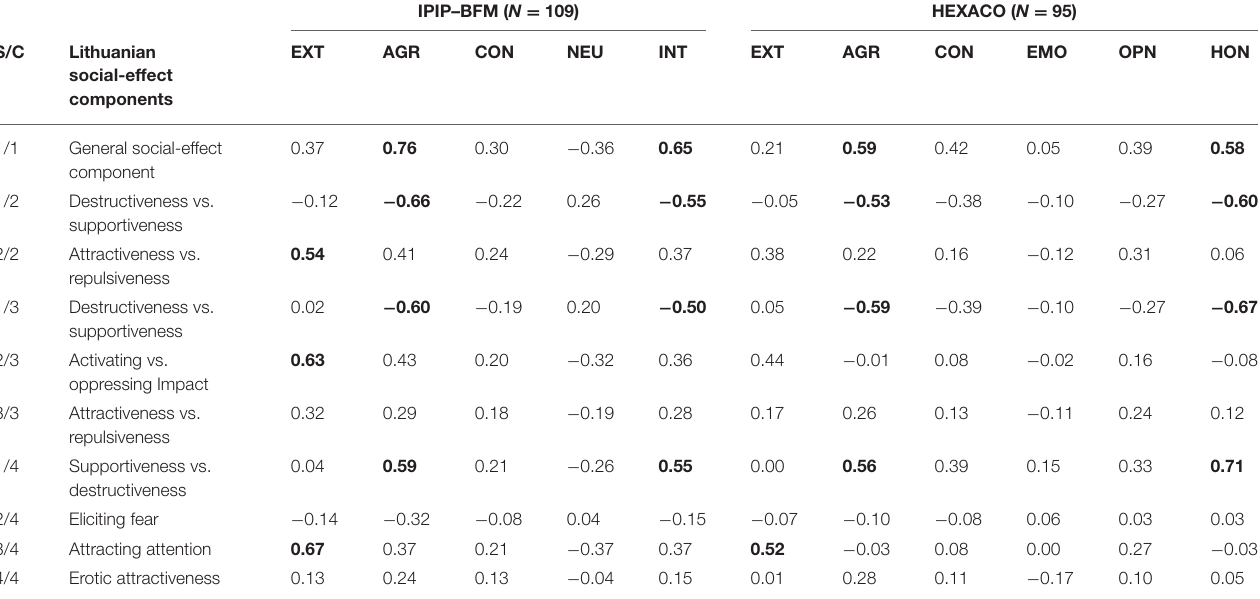
TABLE 4 | Social effects upon perceived personality traits.